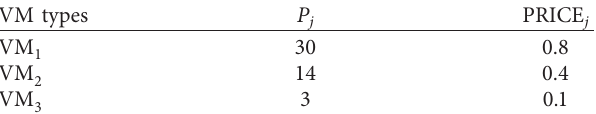
Table 2: Sample virtual